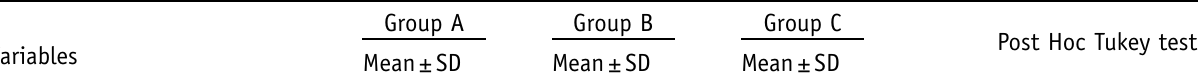
Table I. Descriptive analysis showing mean, standard deviation (SD) and Post Hoc Tukey test of histological variables of Group A, B and C at day 7.